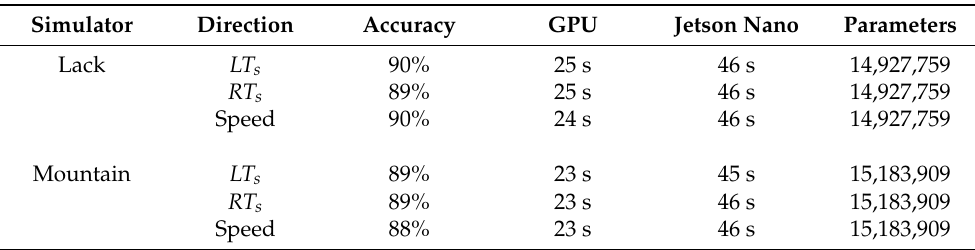
Table 7. Comparison of the performances of our proposed framework when used with an embedded system and the GPU in terms of the runtime for a single epoch and